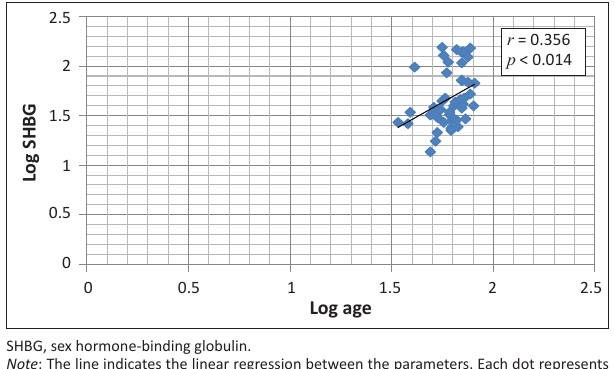
FIGURE 1: Scatter plot showing the relationship between insulin resistance and levels of sex hormone-binding globulin.